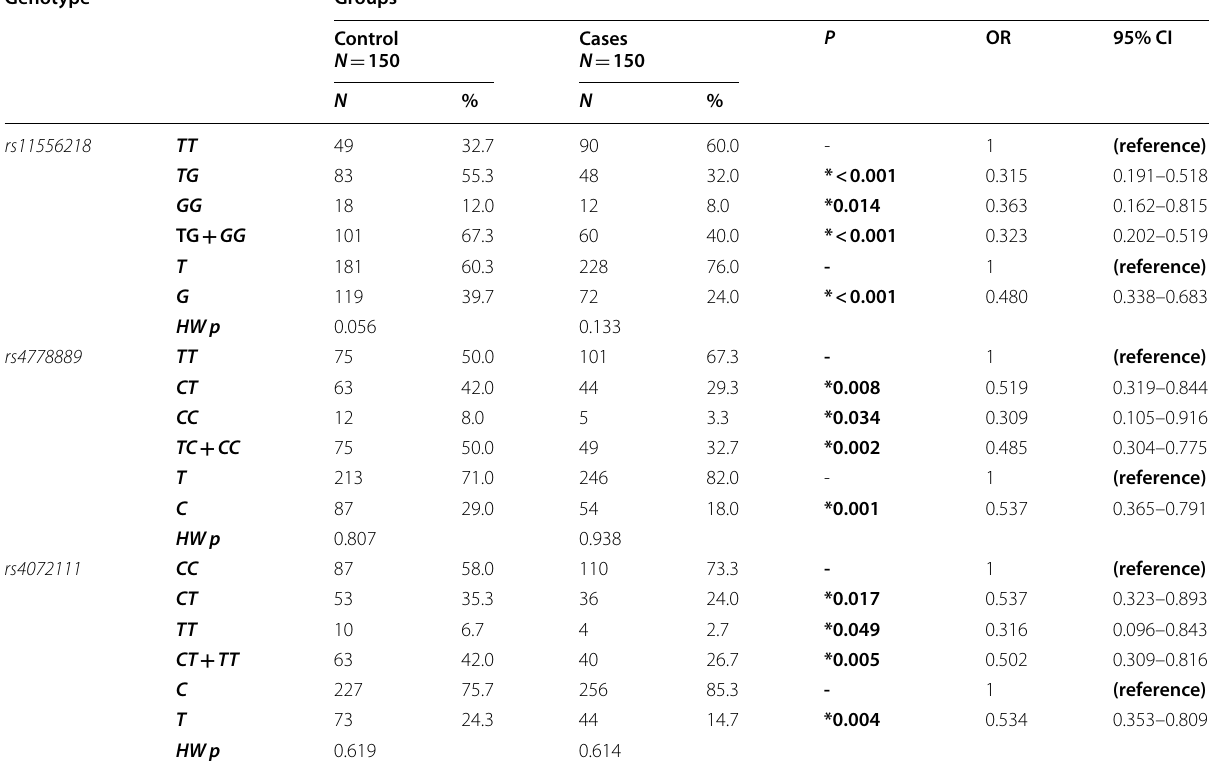
Table 2 Comparison of IL16 SNPs between OA patients and controls